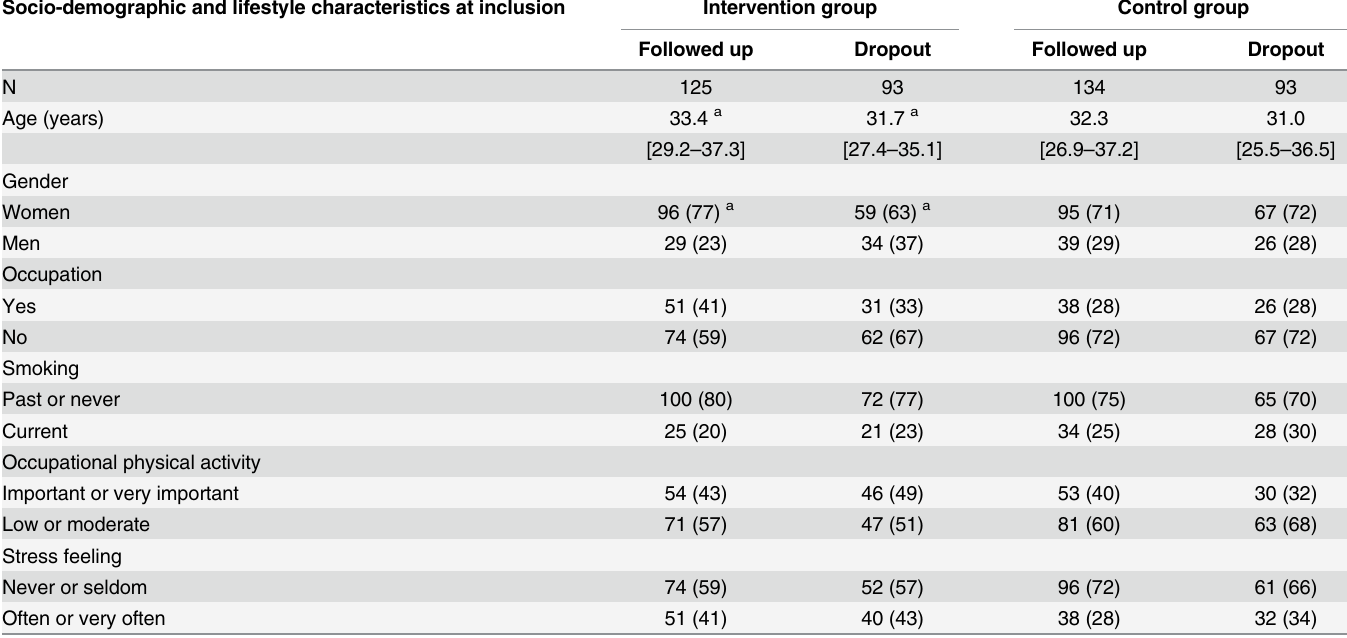
Table 1. Baseline characteristics of the high-risk subjects according to exposure-group and follow-up status. Socio-demographic and lifestyle characteristics at